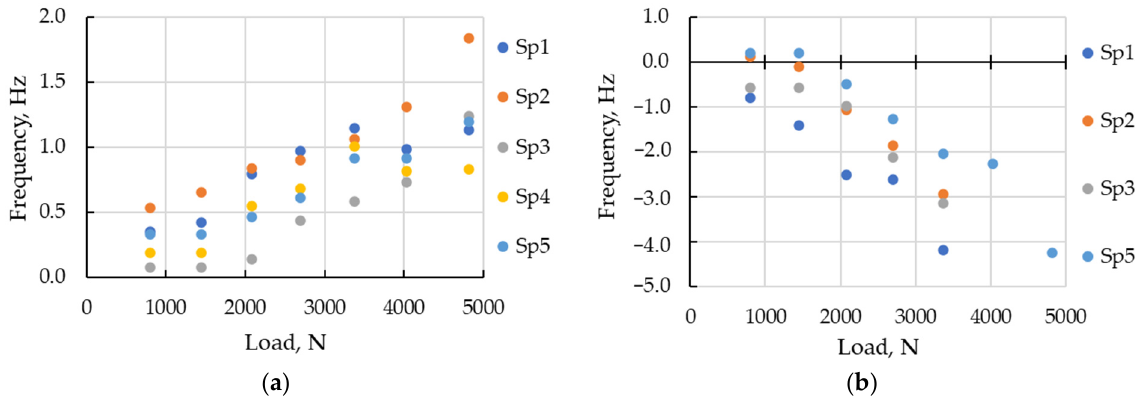
Figure 9. Modal frequency dependence on static load: ( a ) mode (1;5); ( b ) mode (1;2).